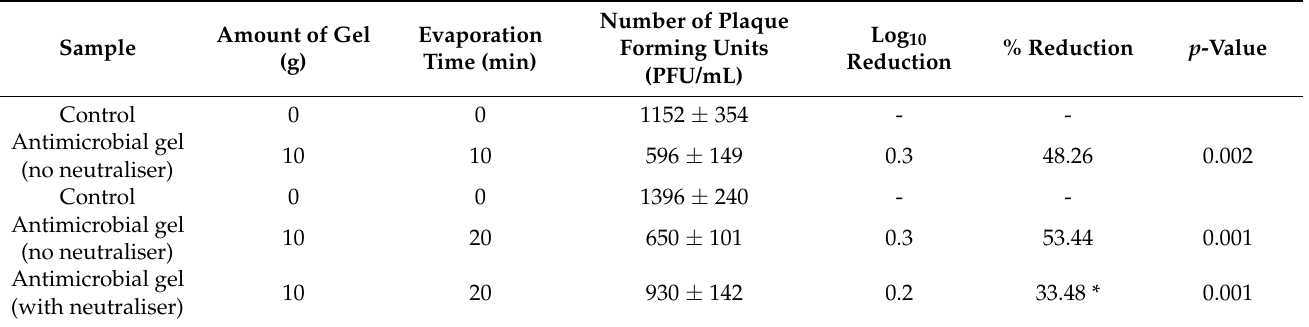
Table 2. Ability of vapours of essential oils to reduce the infectivity of aerosolised murine hepatitis virus.